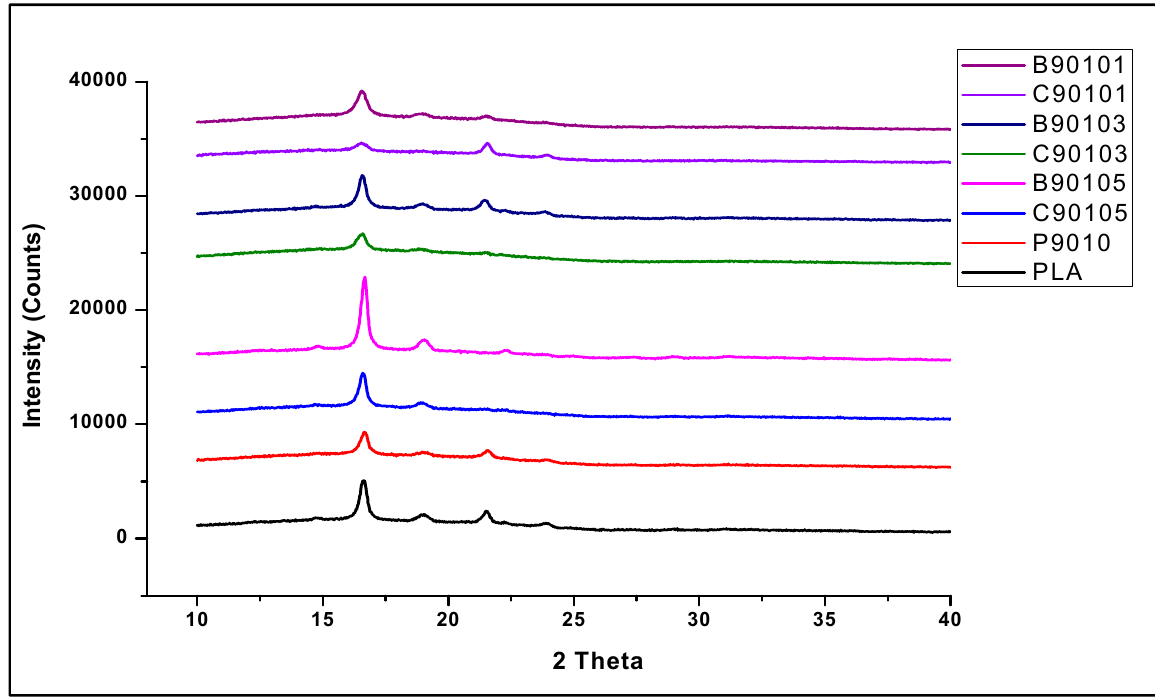
Figure 6. ( a ) Comparative analysis of the FT ‐ IR properties of bamboo and commercial CNF ‐ reinforced biocomposites; ( b ) Schematic chemical bonding in CNF ‐ reinforced biocomposites using ChemDraw software.